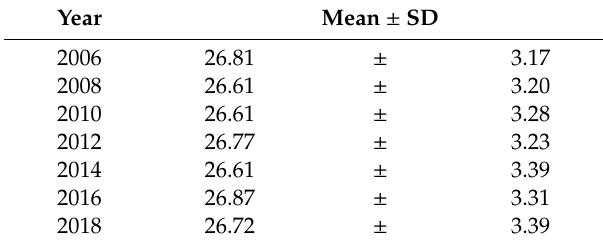
Table 2. Mean MMSE scores by survey year.